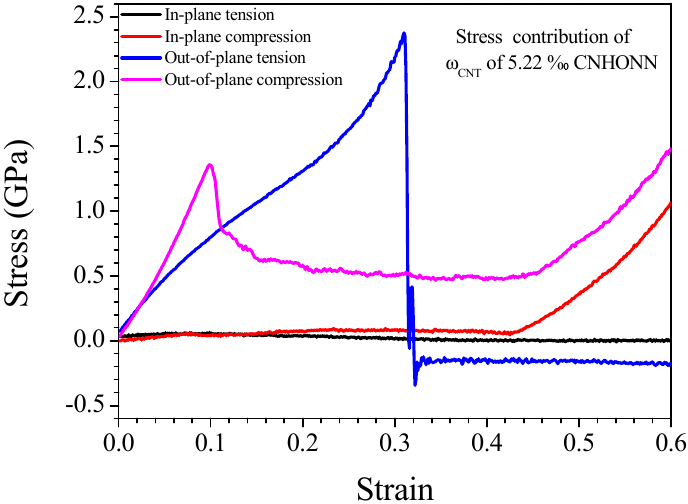
Figure 6. Stress contribution of CNTs in the CNHONN in the case of ω CNT of 5.22‰ along different deformation direction.